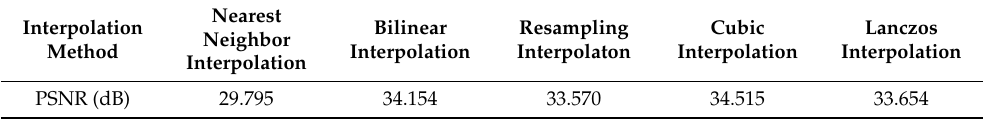
Table 1. Comparison of classical interpolation